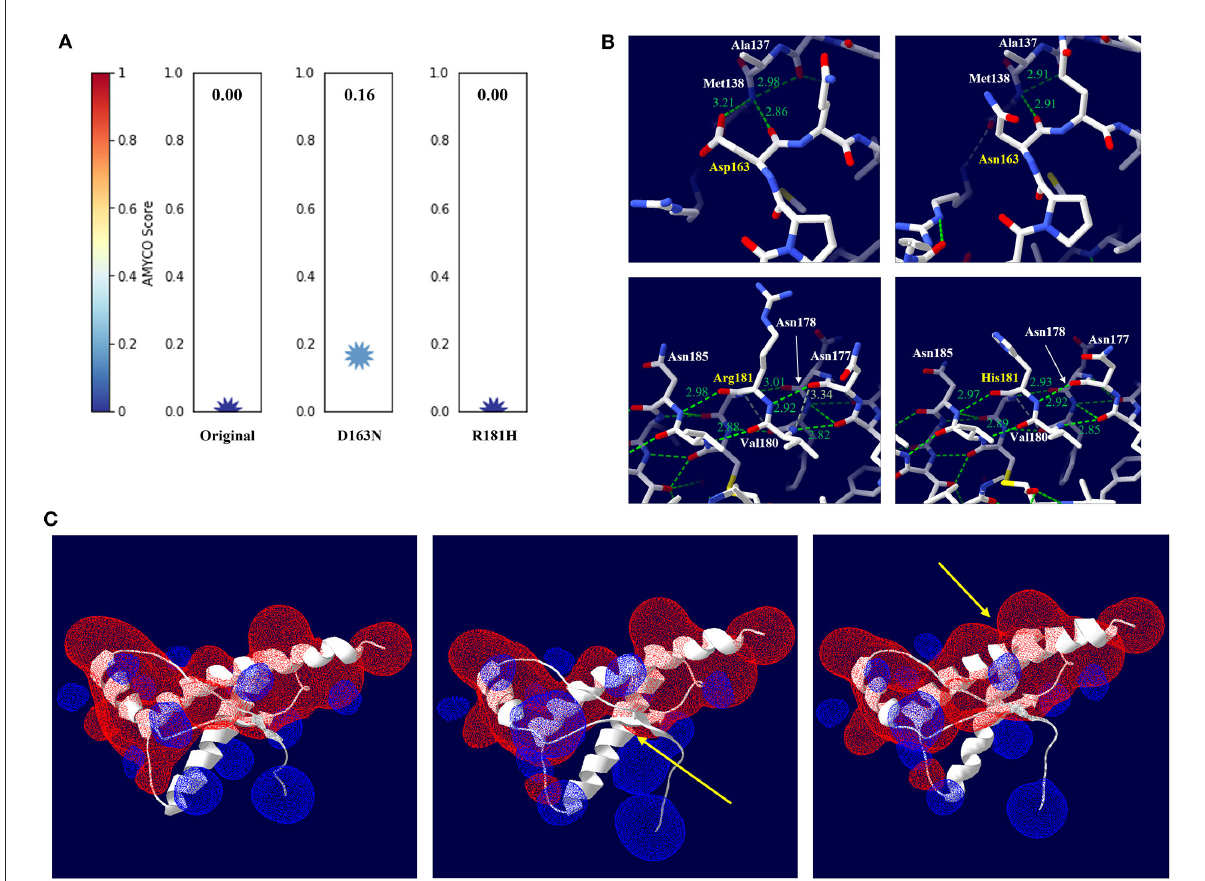
FIGURE3 In silico evaluation of impact according to amino acid substitutions from Canidae family-specific amino acids to interspecies-conversed amino acids. (A) Evaluation of the impact according to the amino acid substitutions by AMYCO. (B) Hydrogen bond analysis according to substitutions by the Swiss-PdbViewer program. The upper left panel indicates raccoon dog PrP with the D163 allele. The upper right panel indicates raccoon dog PrP with the N163 allele. The lower left panel indicates raccoon dog PrP with the R181 allele. The lower right panel indicates raccoon dog PrP with the H181 allele. The green dotted lines indicate hydrogen bonds. The green numbers indicate the distance of the hydrogen bonds. (C) Electrostatic potential prediction according to substitutions by the Poisson-Boltzmann equation in the Swiss-PdbViewer program. The left panel indicates the electrostatic potential of wild-type raccoon dog PrP. The middle panel indicates the electrostatic potential of raccoon dog PrP with the N163 allele. The right panel indicates the electrostatic potential of raccoon dog PrP with the H181 allele. Positive potentials are noted in blue. Negative potentials are drawn in red. The yellow arrows highlight remarkable electrostatic potential changes compared with the wild-type raccoon dog PrP.